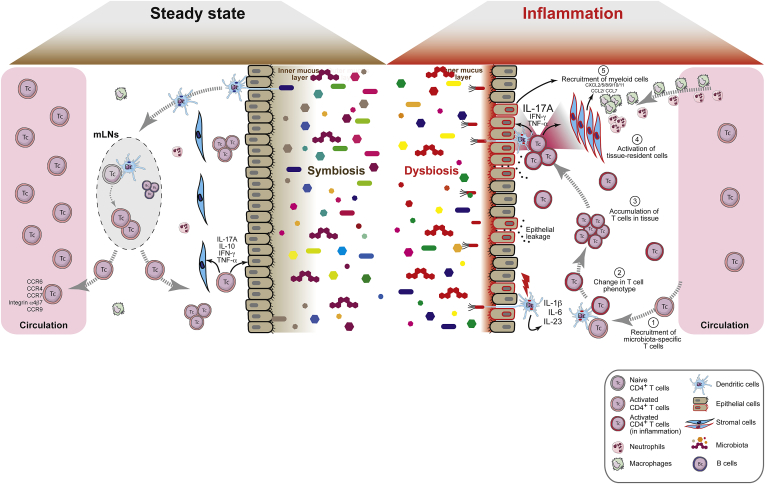
Microbiota-specific memory T-cell responses in intestinal homeostasis and inflammation. Microbiota-specific memory CD4+ T cells are abundant in peripheral blood and mucosa. Luminal sampling of intestinal microbiota by dendritic cells and repetitive epithelial breaches after birth might induce CD4+ T-cell responses targeted towards intestinal bacteria. Enteric bacteria-specific CD4+ T cells produce barrier-protective cytokines, such as IL17A, IFN-gamma, and IL22. Furthermore, certain commensal-specific CD4+ T cells also produce IL10. We speculate that the cytokine production by commensal-specific CD4+ T cells might play a significant role in supporting gut homeostasis and the mutualistic relationship with intestinal microbiota. In inflammation, epithelial break down and leakage leads to increased availability of luminal antigens and bacterial stimuli, which activate the innate system and the expression of Th17-inducing cytokines (IL1β, IL6, and IL23). Recruited microbiota-specific memory CD4+ T cells accumulate in inflamed mucosa and are polarized toward more IL17A production. Activated memory cells express IL17A, TNF-α, and IFN-gamma, which stimulate intestinal cells, such as stromal and epithelial cells, to express various chemokine ligands and cytokines. This may promote recruitment and activation of myeloid cell populations.